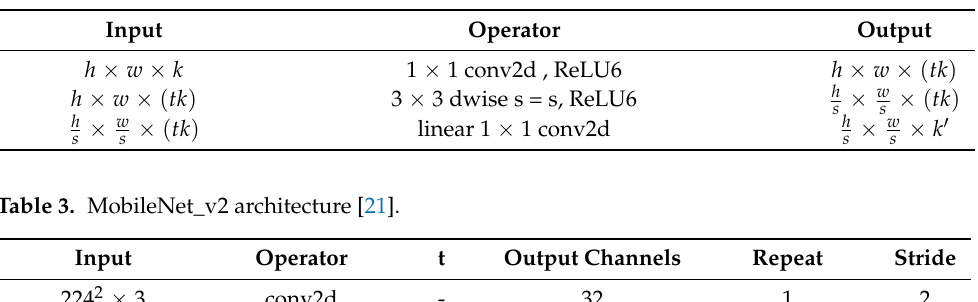
Table 2. Bottleneck residual block transforming from k to k (cid:48) channels, with stride s, and expansion factor t, height h, and width w [21].